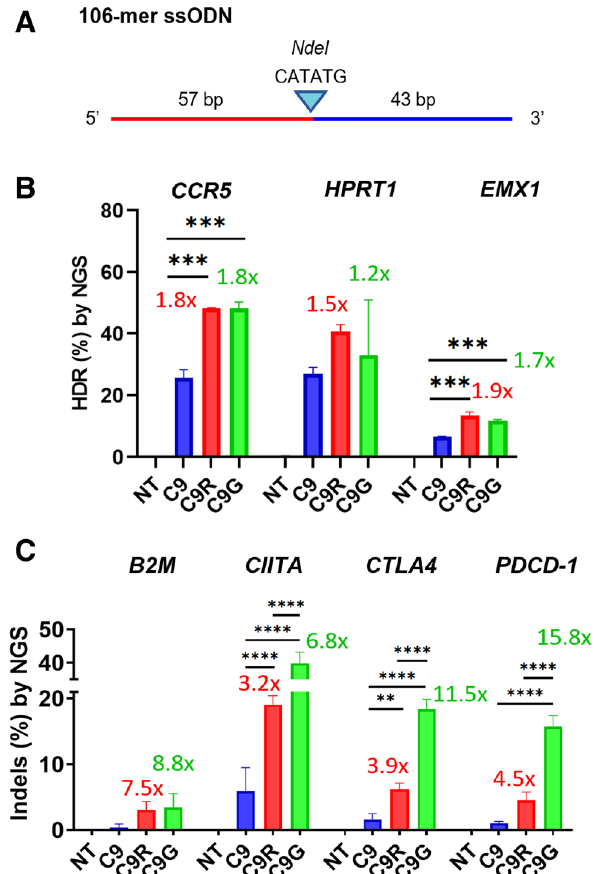
Figure 2. Increase in knock-in efficiency in HEK293T cells and enhanced multiplex indel efficiency of chimeric proteins in iPSCs. ( A ) Schematic of a 106-mer single-stranded oligonucleotide (ssODN). Artificially introduced NdeI restriction site (blue triangle) was flanked with homologous 5 ′ arm (57-mer) and 3 ′ arm (43-mer). ( B ) Comparison of homology-directed DNA repair (HDR) activity among C9, C9R, and C9G. HDR efficiency was evaluated by targeted deep sequencing of the CCR5 , HPRT1 , and EMX1 loci (left to right) after genome editing with the specific 106-mer template shown in panel a. (**** P < 0.0001 and *** P < 0.001, one-way ANOVA using Tukey’s multiple-comparison test). For each gene, fold change was calculated relative to C9 efficiency. ( C )